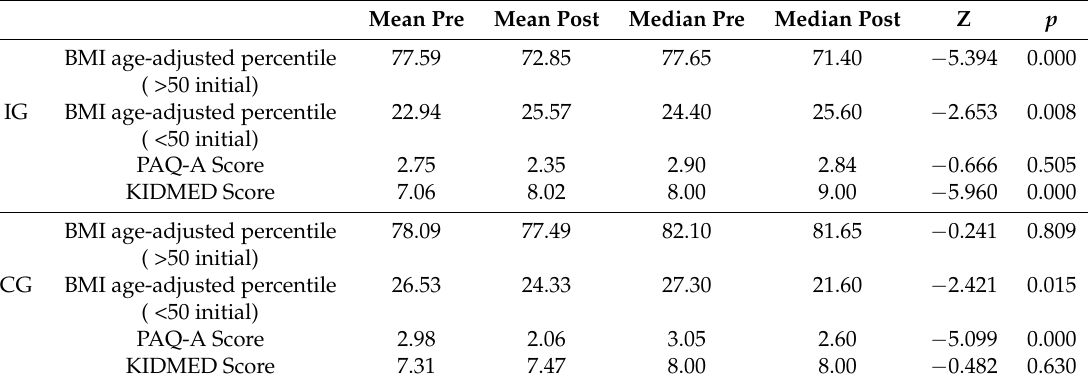
Table 3. Changes in BMI age-adjusted percentile, KIDMED score and PAQ-A score in intervention group (IG) and control group